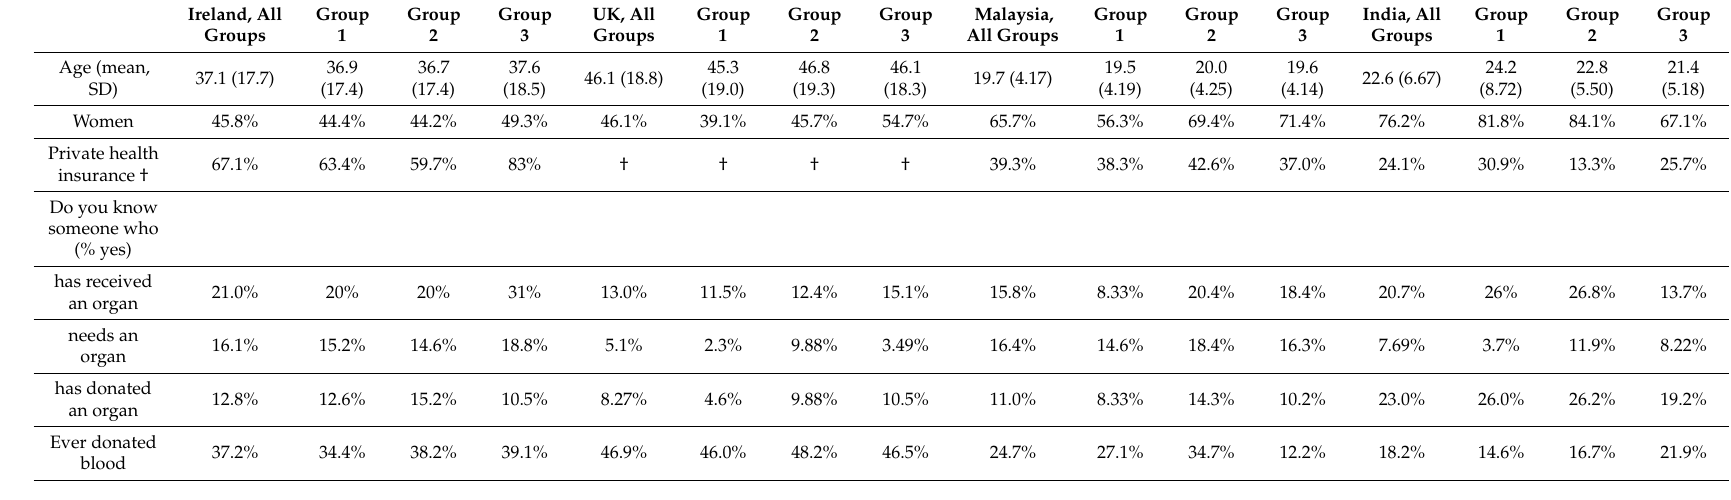
Table A1. Sample description by country for study